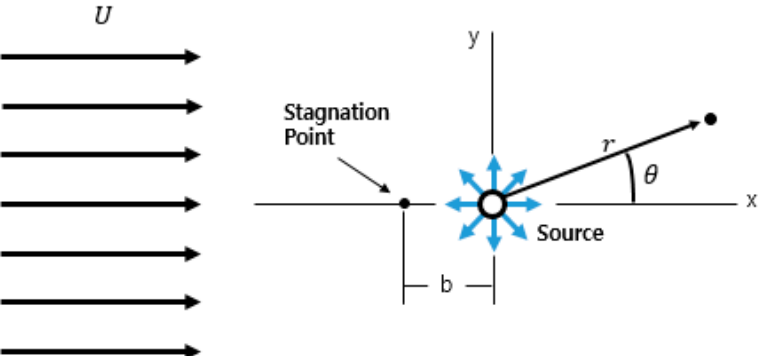
Figure 2. Superposition of source flow and uniform flow.